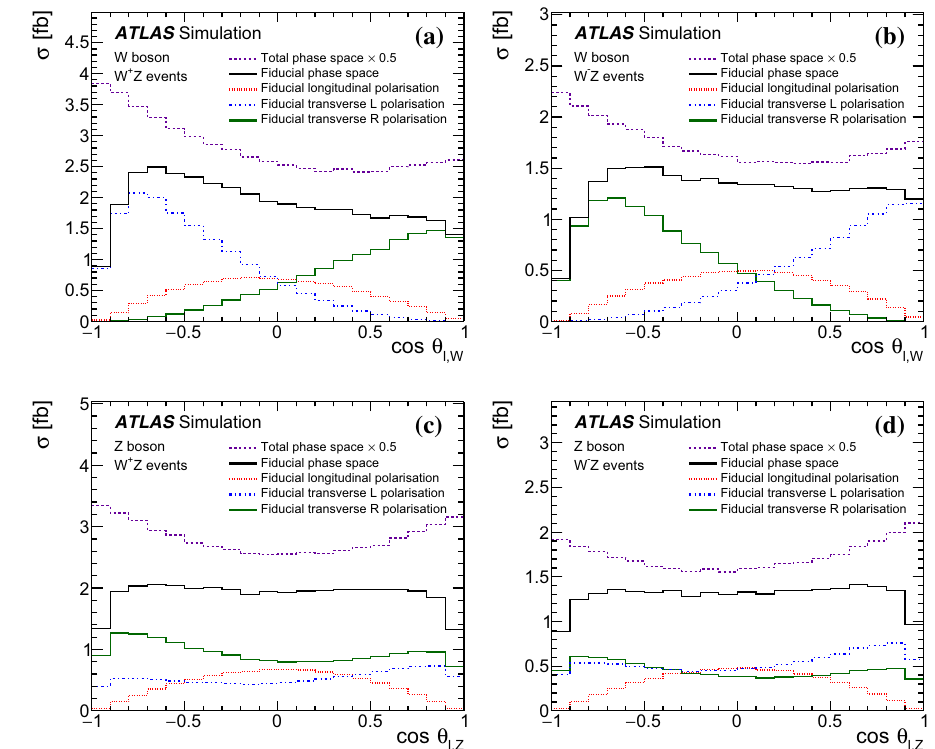
Fig. 8 Distributions in the total and fiducial phase space at particle level of the variables a , b cos θ (cid:4), W and c , d cos θ (cid:4), Z for a , c W + Z and b , d W − Z events. The black line corresponds to the sum of all helicity states. The red, blue and green lines correspond to the purely longitudinal, transverse left-handed and transverse right-handed helicity components, respectively. The distributions are obtained using the Powheg+Pythia MC. All four decay channels, eee , e μμ , μ ee , and μμμ , are added together